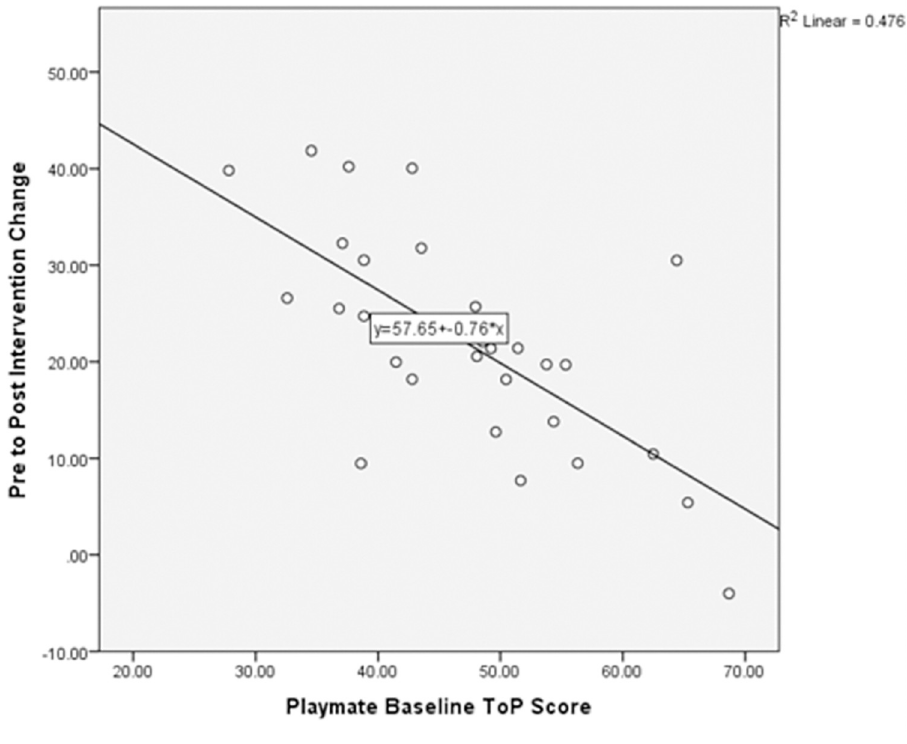
Fig 2. Variables that correlated with intervention